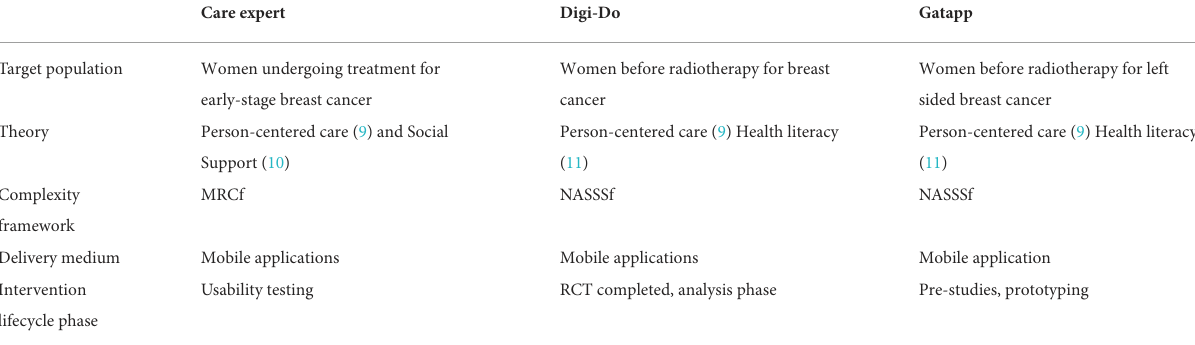
TABLE 1 Main features of the individual DHIs